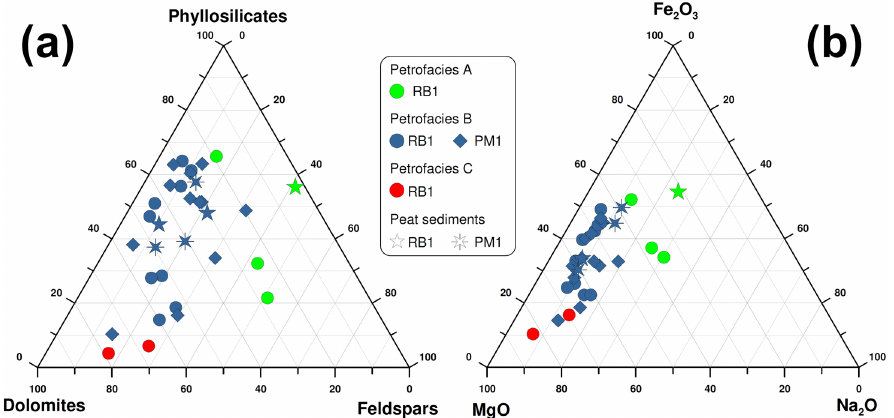
Figure 8. Ternary diagram reporting the main selected mineral components (a) and geochemical components (b) of the bulk sediments in the RB1 and PM1 cores. Peat samples are represented by the two star-like symbols.